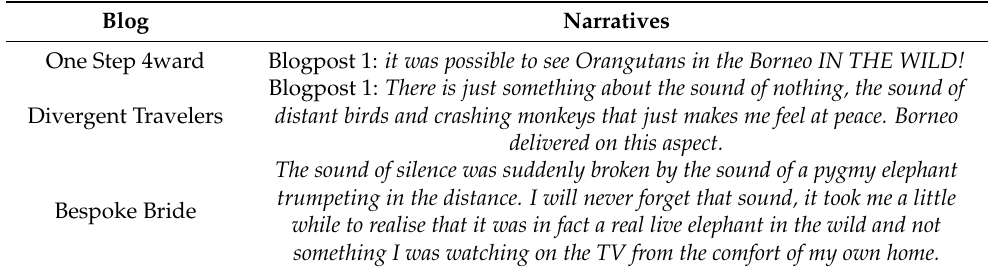
Table 3. Emotional Narratives on Theme Nature.